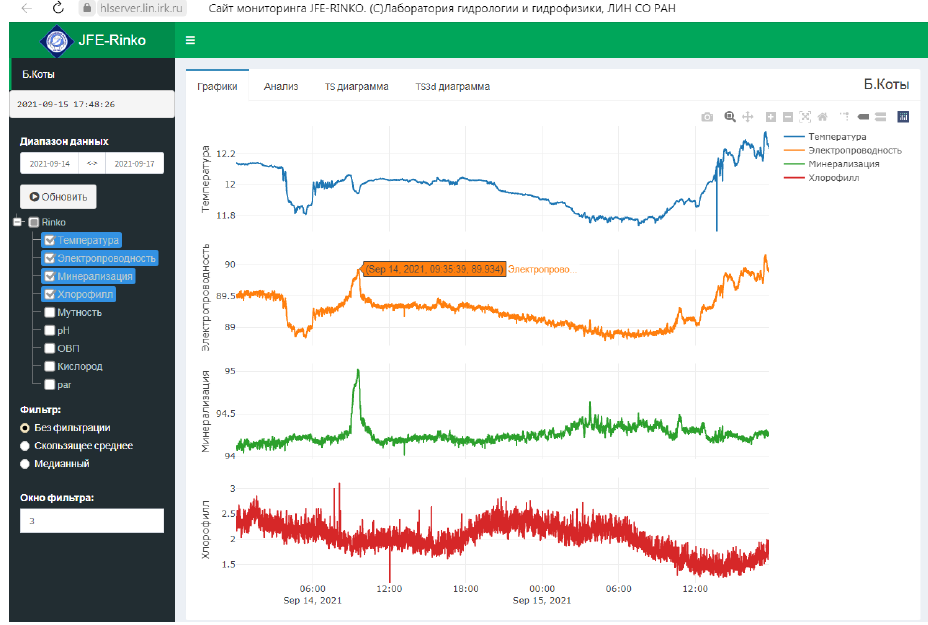
Figure 3. Web interface access to the AHMS